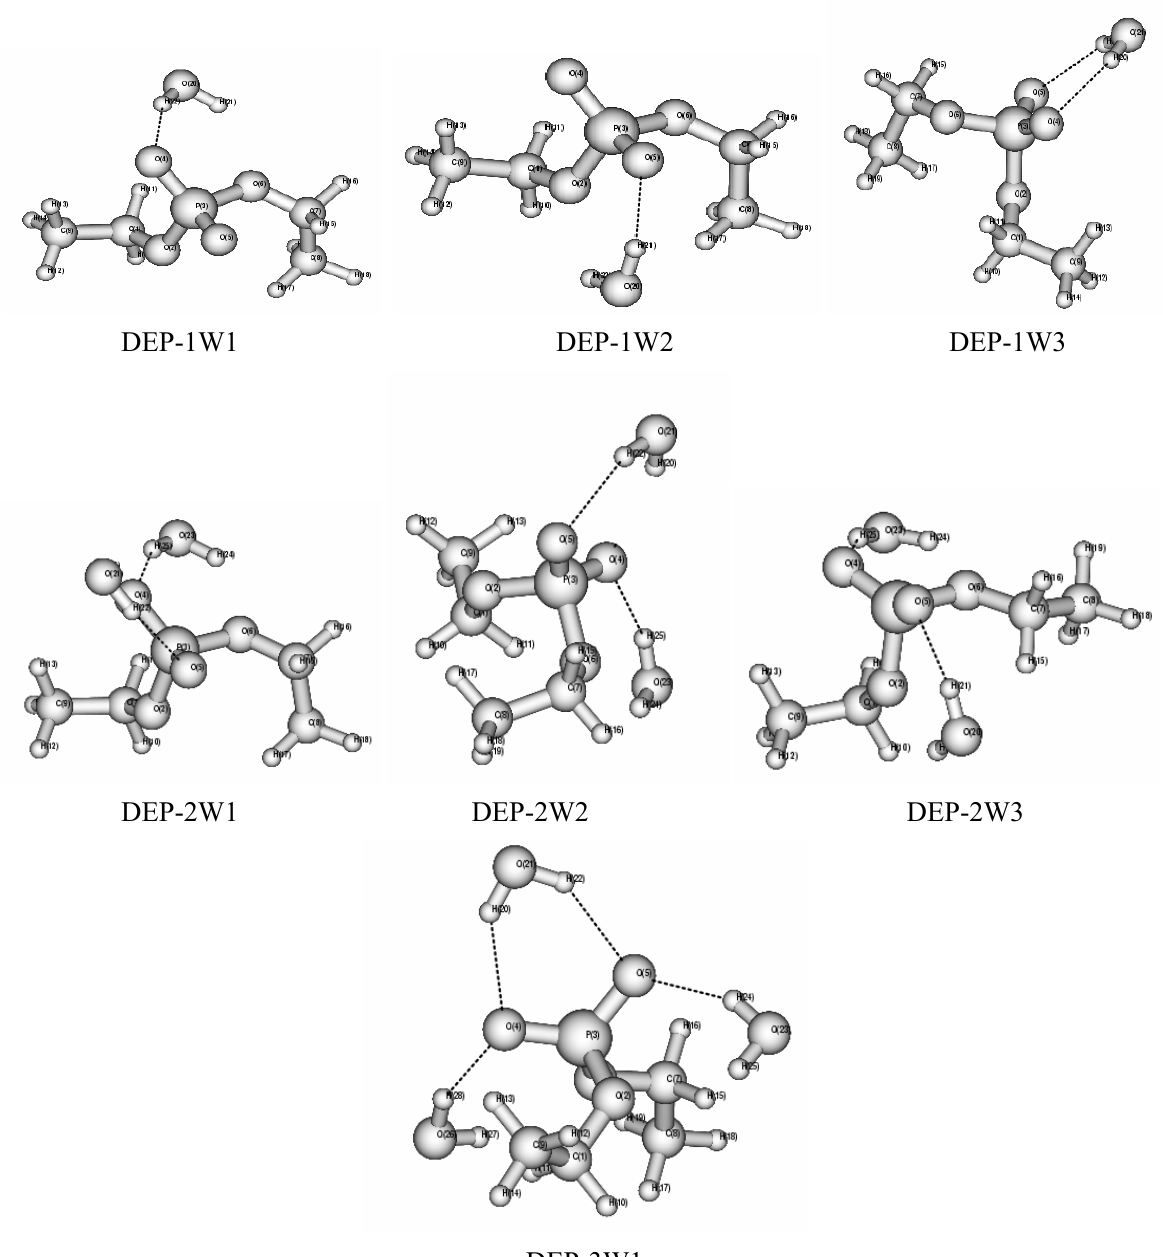
Figure 3. Structures of the DEP anions interacting with one, two, and three water molecules